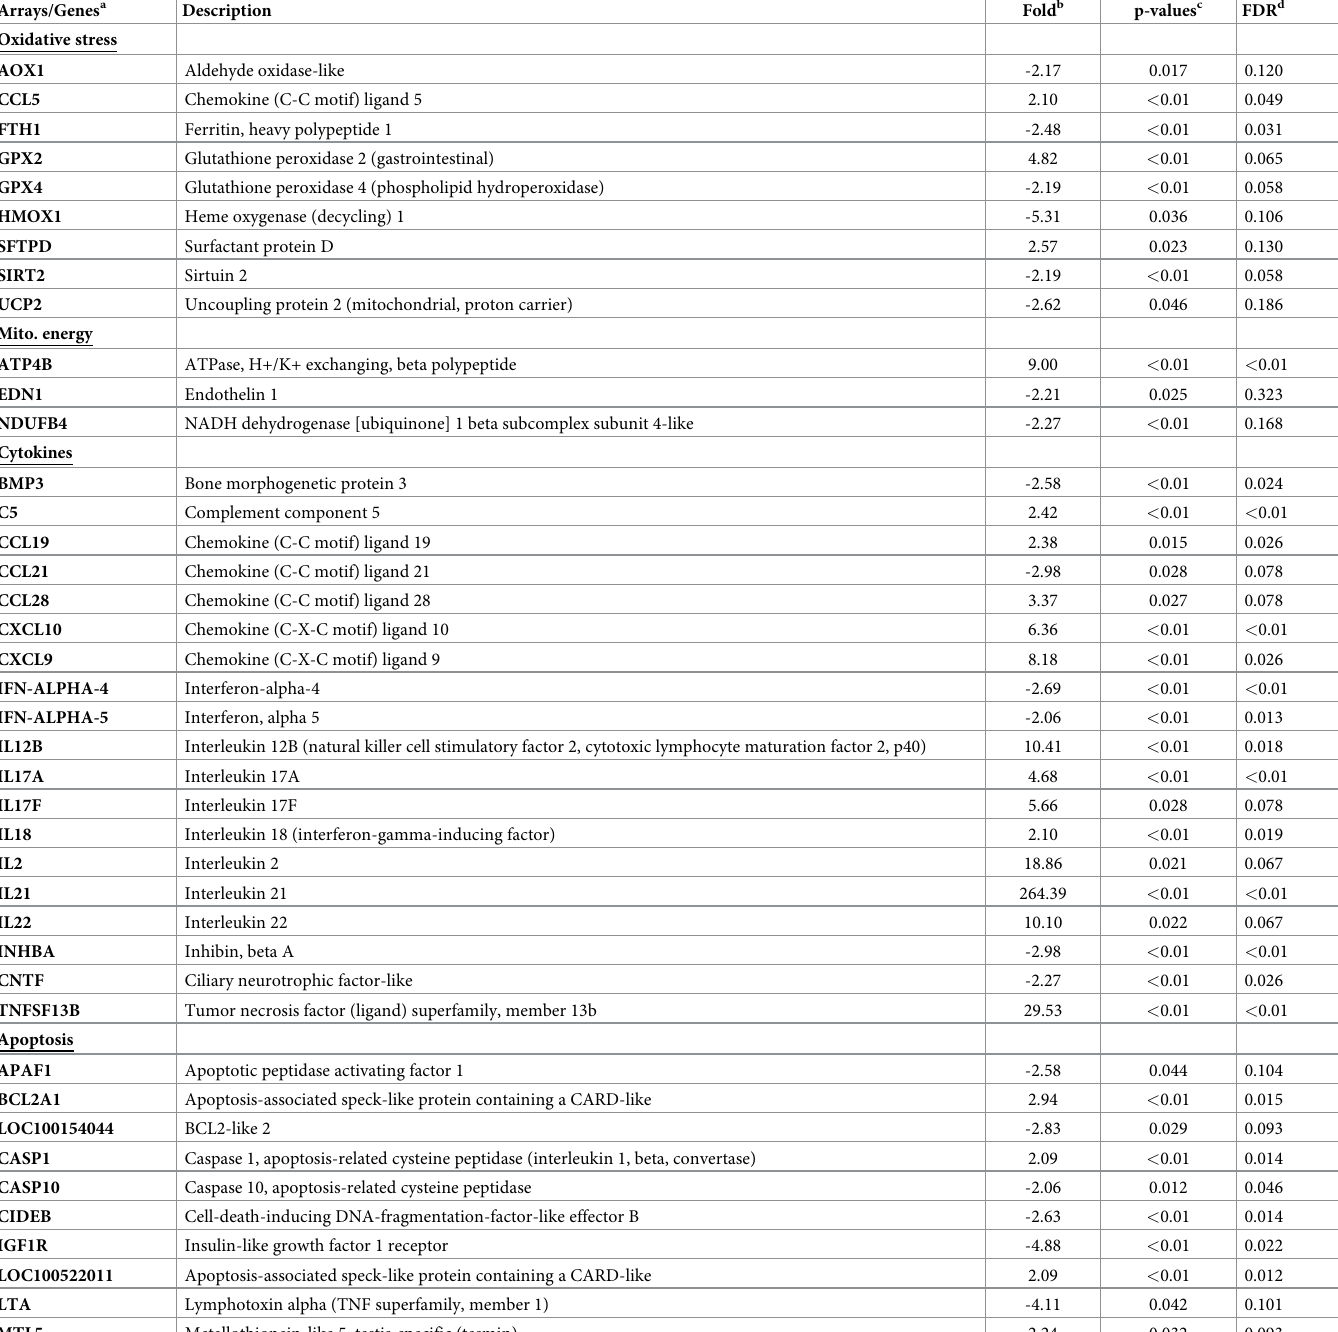
Table 4. Differently expressed genes identified by RT 2 -profilers arrays in the intestinal mucosa of 35 versus 14 days old Normal Birth Weight (NBW) piglets. Arrays/Genes